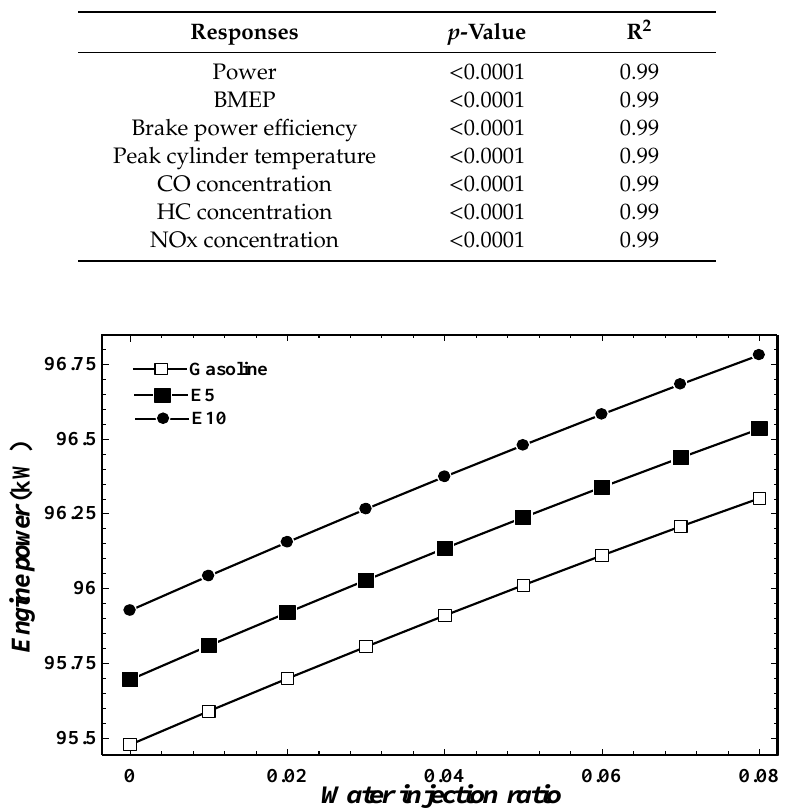
Figure 6. Engine power output in various water injection ratios for each fuel.